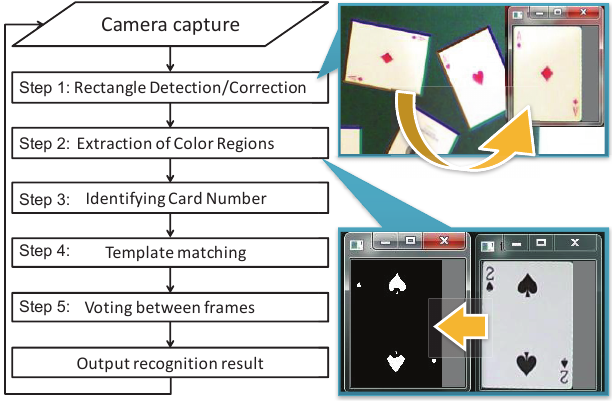
Figure 3. Card recognition